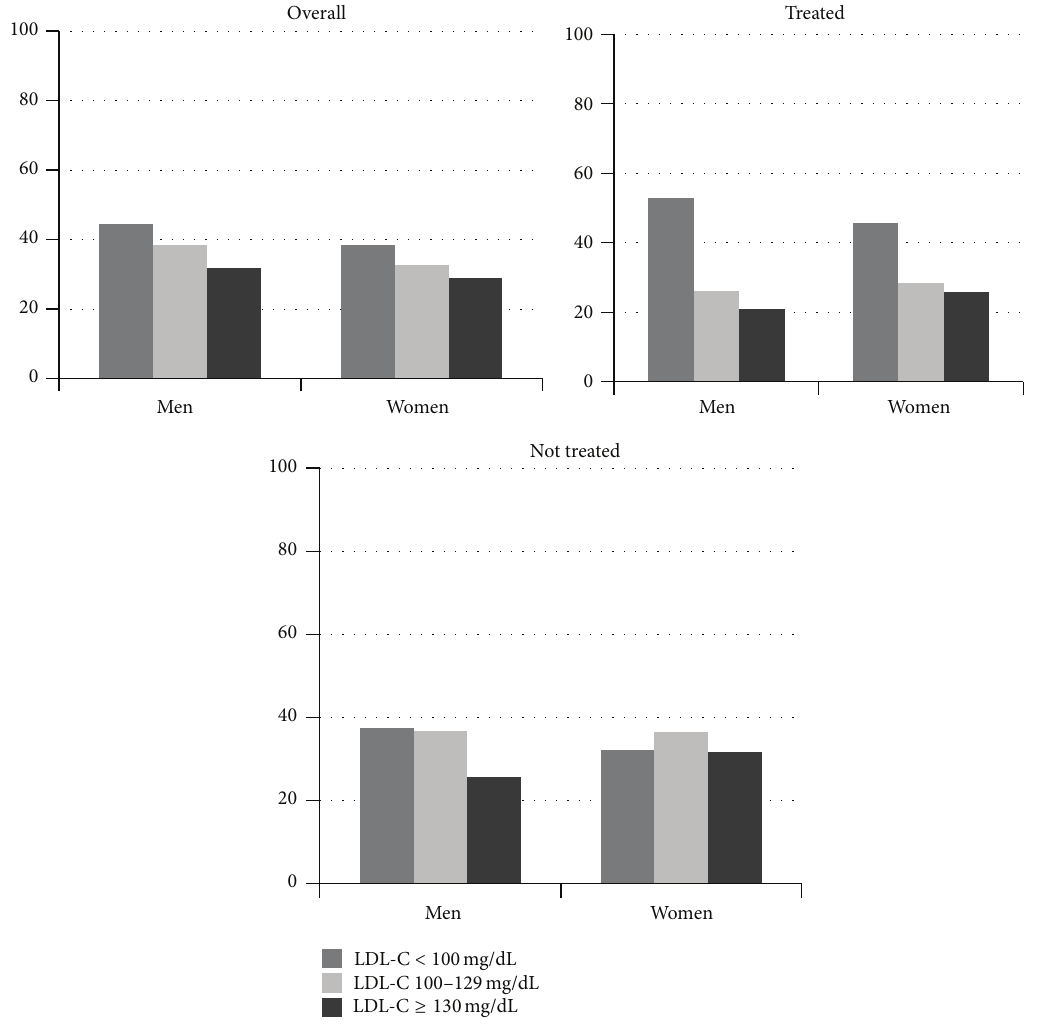
Figure 1: LDL-C classes according to gender and lipid-lowering